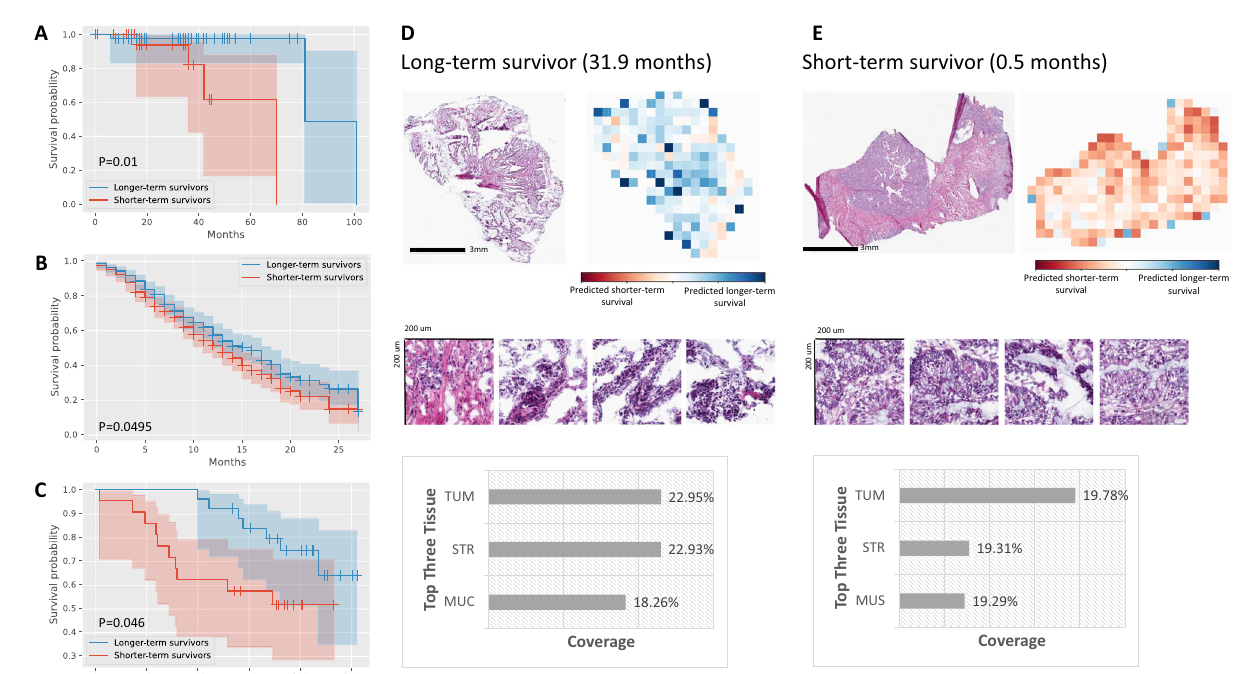
Fig. 2 | MOMA predicts overall survival outcomes of stage I and II colorectal cancer patients using digital histopathology images, with validation in mul- tiple independent cohorts. A MOMA successfully distinguishes the shorter-term survivors from longer-term survivors using histopathology images (two-sided log- rank test P -value= 0.01). Results from the TCGA held-out test set are shown. B The machine learning model derived from MOMA is successfully validated in an inde- pendent external validation set from the Nurses ’ Health Study and Health Profes- sionals Follow-up Study cohorts (two-sided log-rank test P -value<0.05). C We further validate our overall survival prediction model in PLCO, a